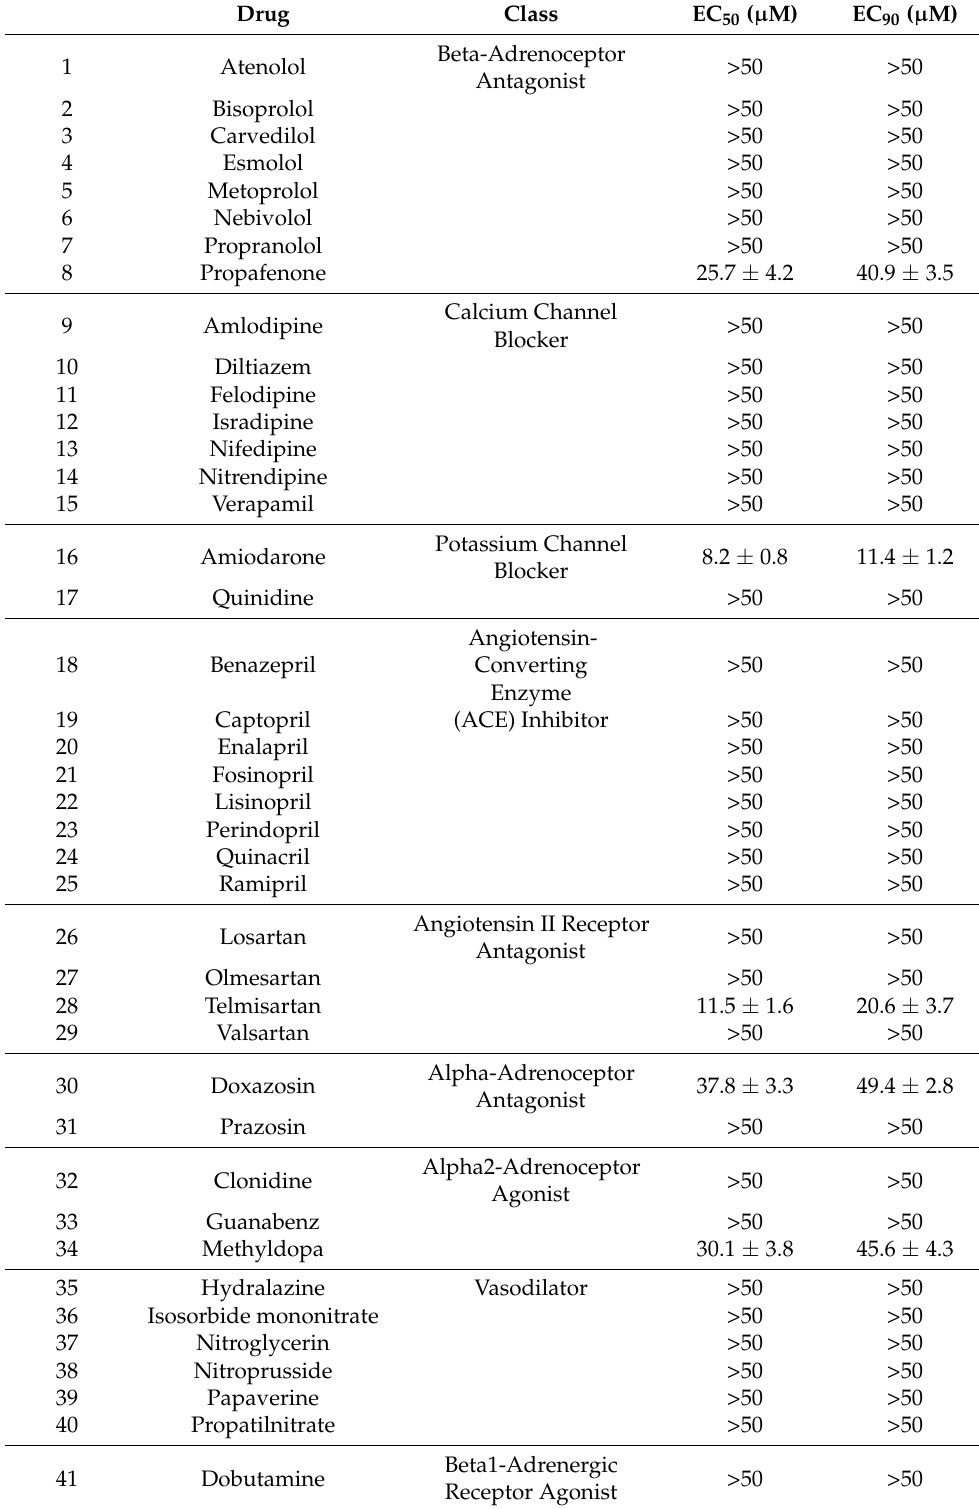
Table 1. In vitro activity of cardiovascular agents against S. mansoni adult